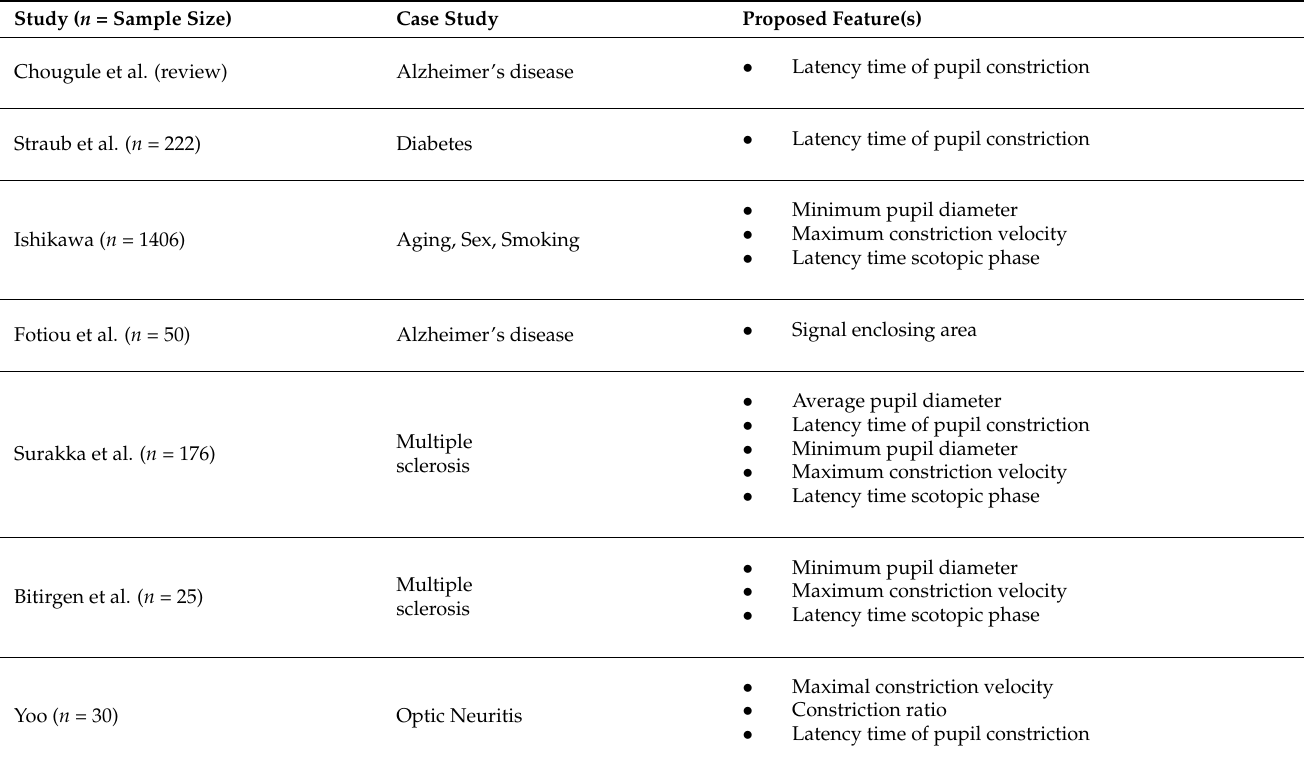
Table 1. Summary of the PLR signal features already proposed in the literature. For each study, we reported the number of patients involved, the analyzed disease, and the set of features proposed for the quantitative analysis. All the features cited in this table were considered in the current work, providing a mathematical equation for their